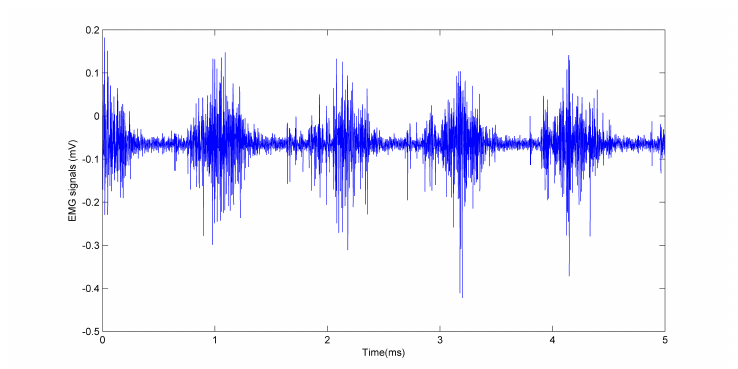
Figure 3. A sample of output data from EMG signals during walking on the treadmills for 5 s.